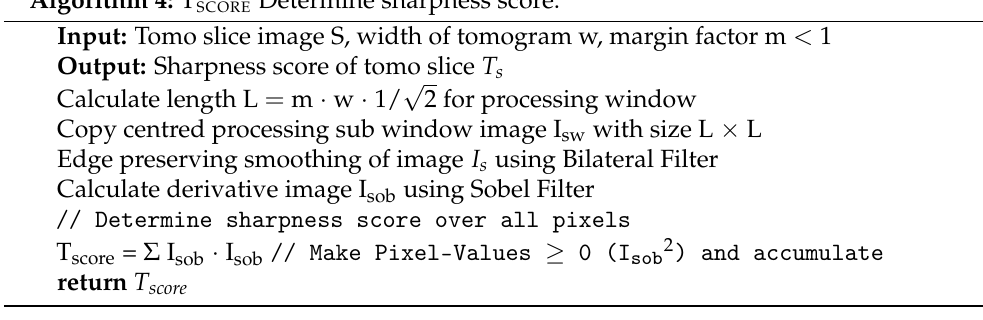
Algorithm 4: T Determine sharpness score. SCORE